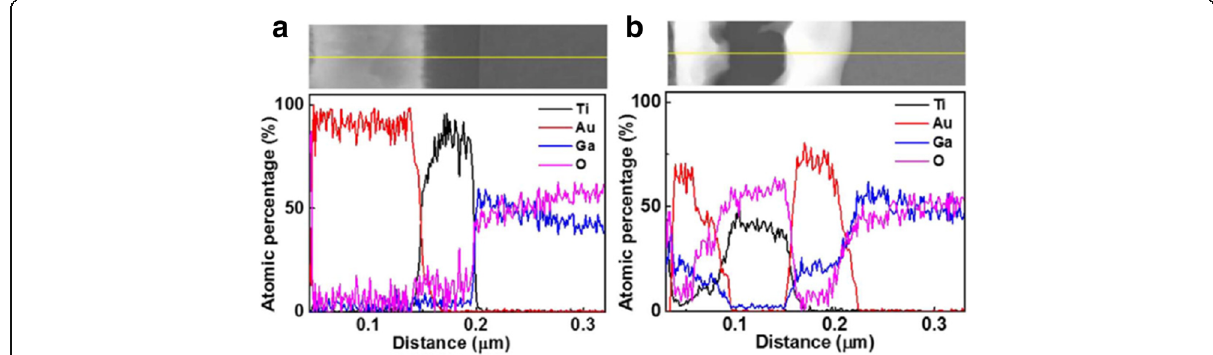
Fig. 8 Atomic percentage profiles by EDS of metallization and β -Ga 2 O 3 a pre- and b post-annealing at a temperature of 500 ° C. Reproduced from Ref. [55]